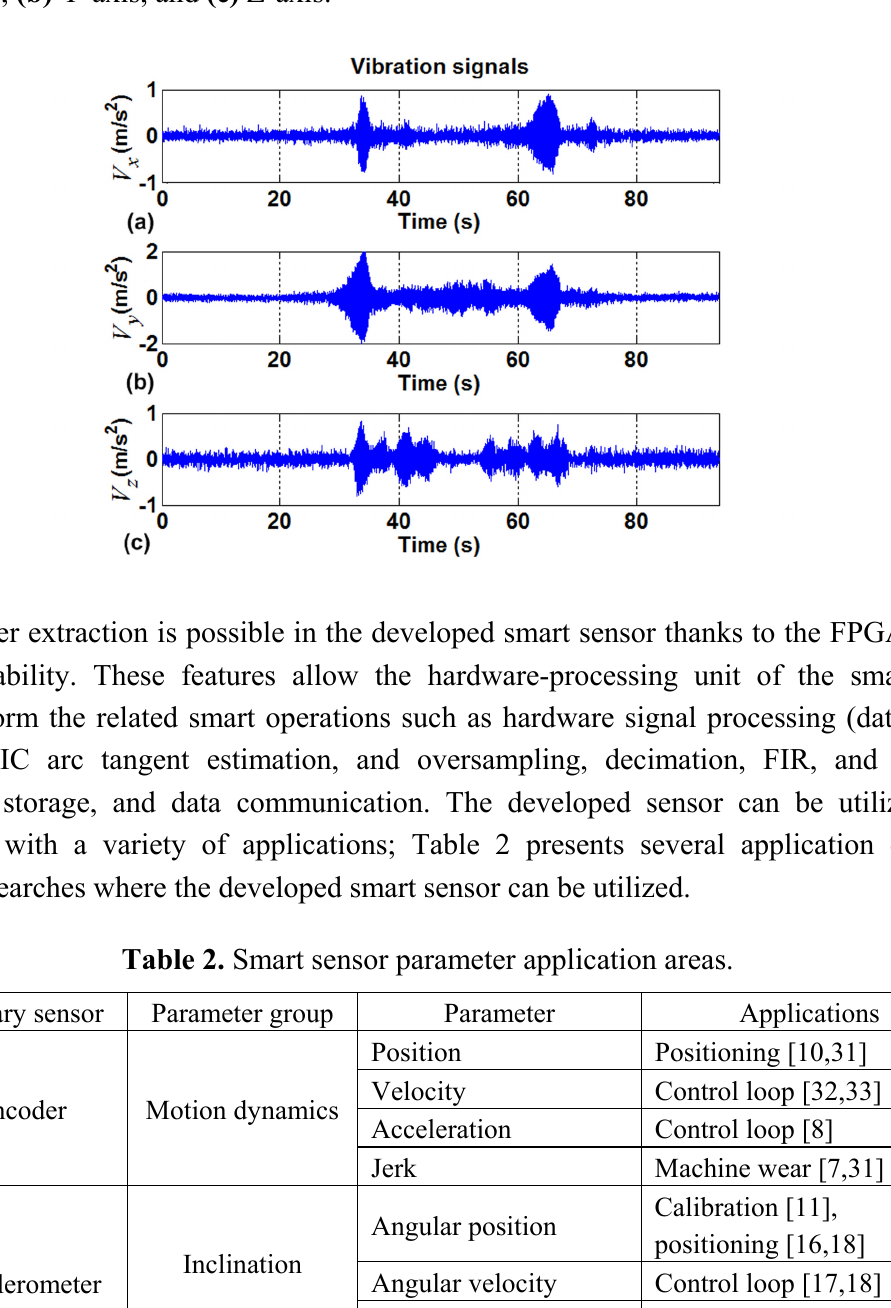
Figure 11. Vibration information separated from inclination at the accelerometer